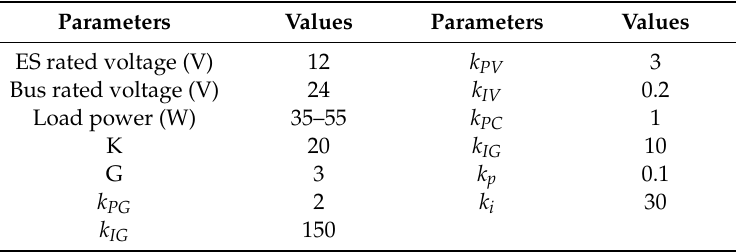
Table 1. Simulation parameters